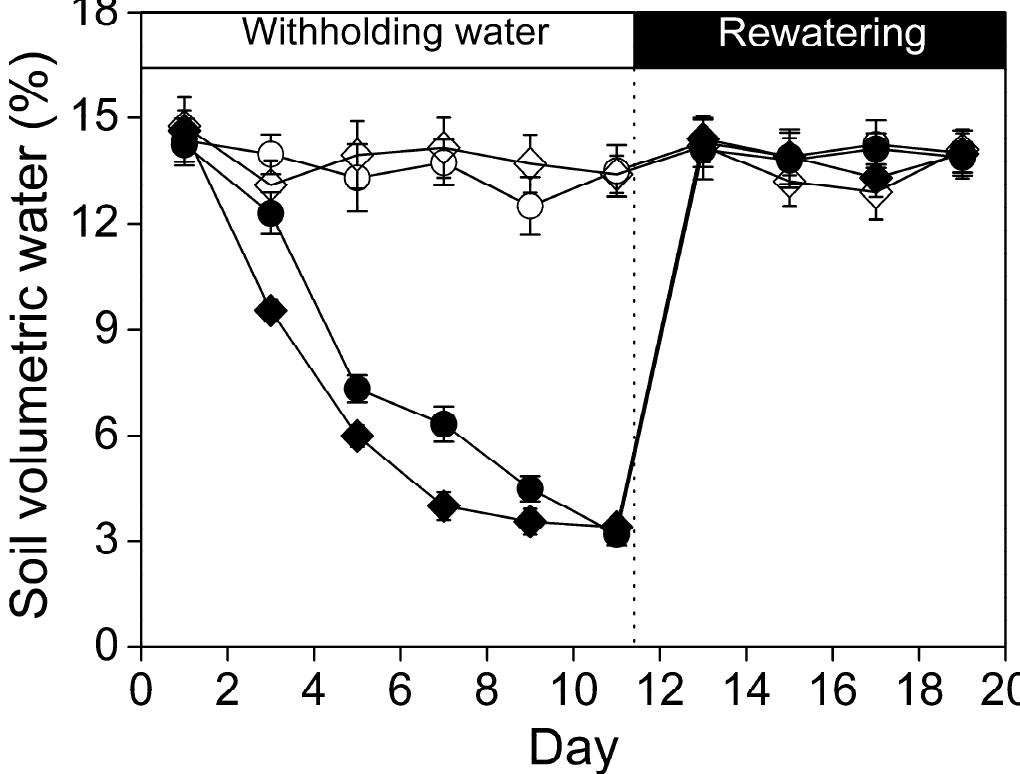
Figure 1. Changes in soil moisture during drought and rewatering for P. centrasiaticum (circle) and C. pseudophragmites (diamond), respectively. Open circles ( ○ ) and diamond ( ◊ ) denote the well-watered treatment, and the filled them denote drought-stressed. The rewatering is indicated by the dotted line. Values are means ± SE ( n = 9).